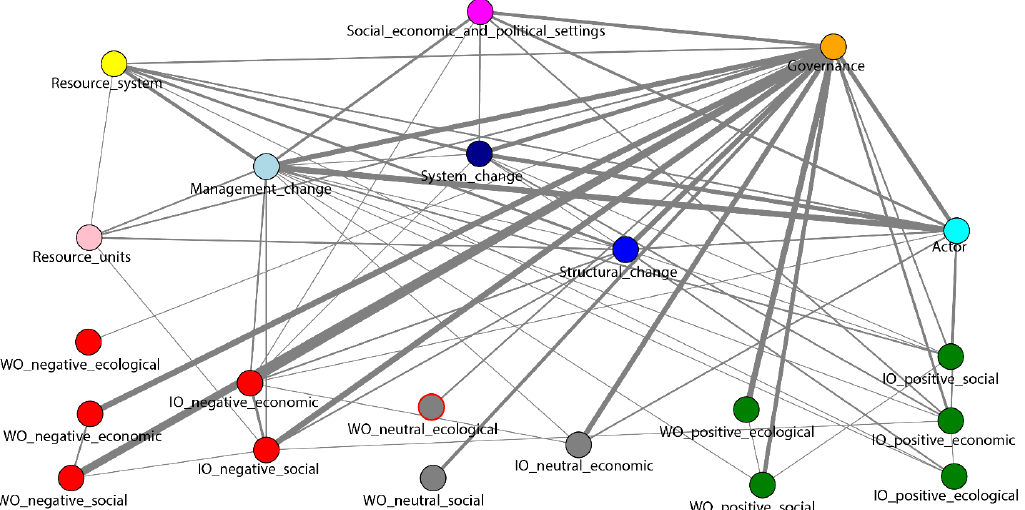
Figure A1.3. Rotorua SES Category group mental model network